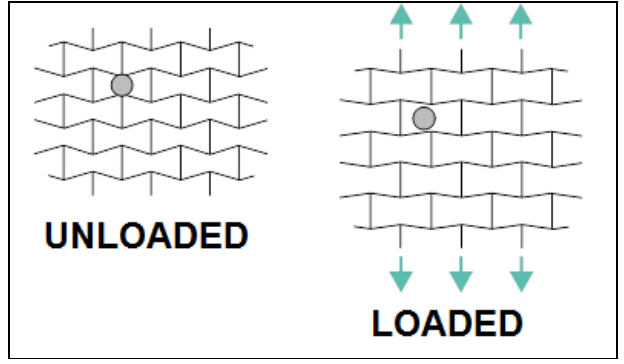
Figure 7. Auxetic membrane